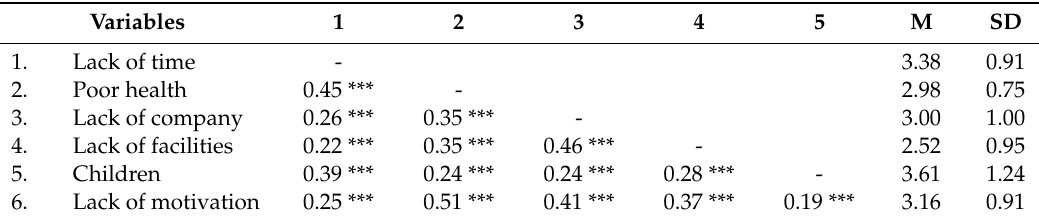
Table 1. Correlations matrices.